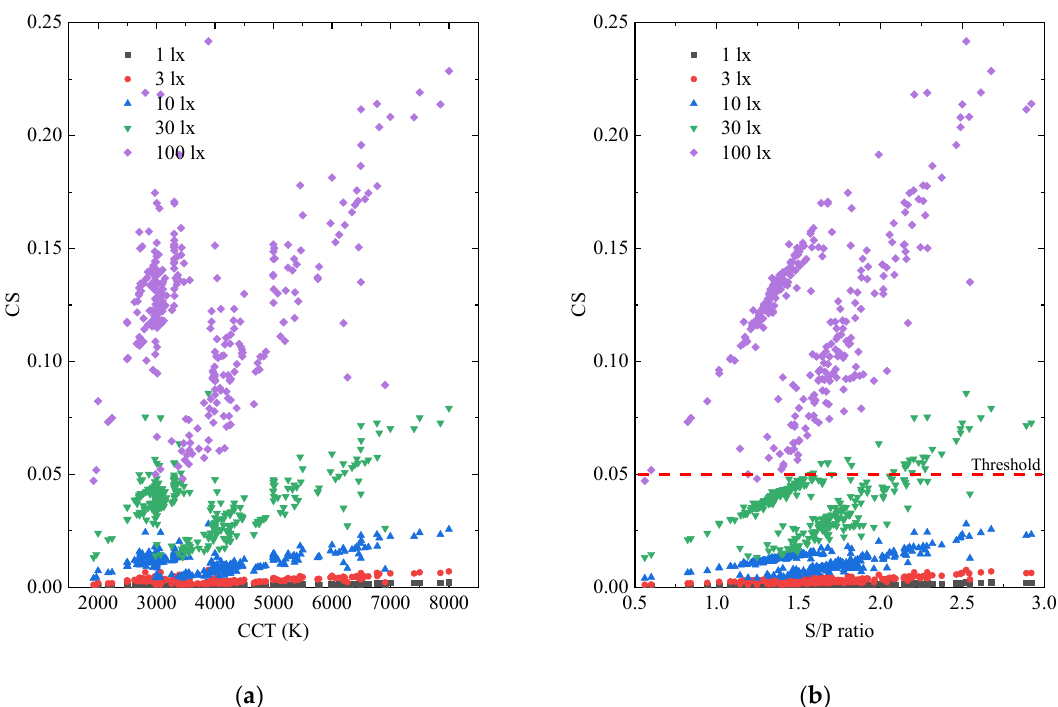
Figure 5. Circadian stimulus (CS) plot against the ( a ) CCT and ( b ) S/P ratio. Table 1. The EML, CL A, and CS of HPS and the low CCT LED and high CCT LED at different photopic adaptation illuminance levels.